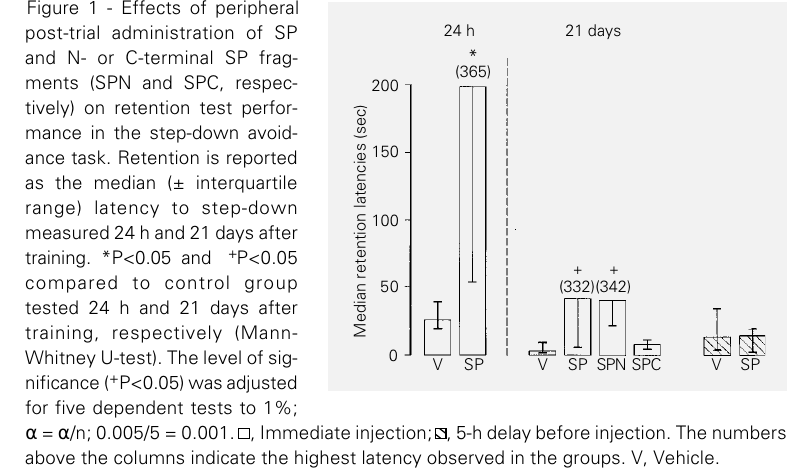
Figure 1 - Effects of peripheral post-trial administration of SP and N- or C-terminal SP frag- ments (SPN and SPC, respec- tively) on retention test perfor- mance in the step-down avoid- ance task. Retention is reported as the median (– interquartile range) latency to step-down measured 24 h and 21 days after training. *P<0.05 and + P<0.05 compared to control group tested 24 h and 21 days after training, respectively (Mann- Whitney U-test). The level of sig- nificance ( + P<0.05) was adjusted for five dependent tests to 1%; a = a /n; 0.005/5 = 0.001. , Immediate injection; , 5-h delay before injection. The numbers above the columns indicate the highest latency observed in the groups. V,